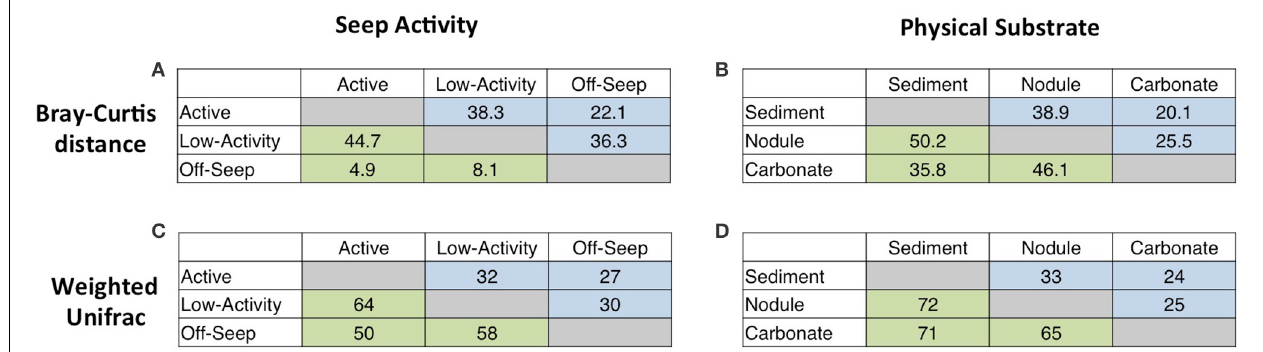
FIGURE 4 | Results from beta diversity analyses of sequences binned by seep activity (A,C) or physical substrate (B,D). (A,B) provide Bray-Curtis similarities derived from comparison of proportional abundances of 97% sequence similarity OTUs. (C,D) Show weighted UniFrac-derived data for which all pairwise P -values are < 0.001.